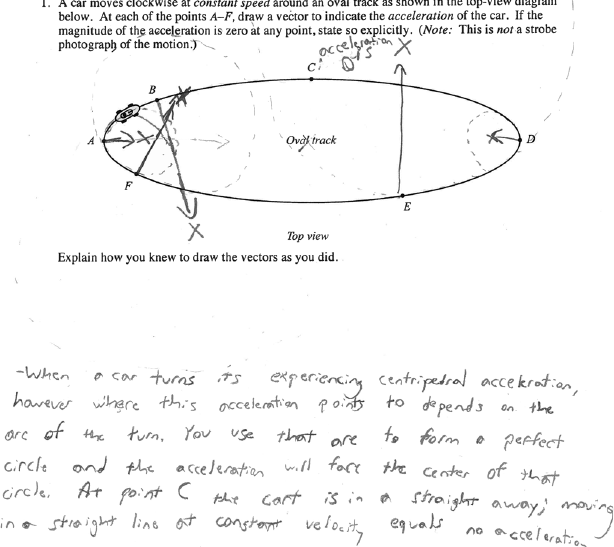
FIG. 2. Felix ’ s tutorial pretest on 2D